Question: Condense the content of this figure into a single sentence.
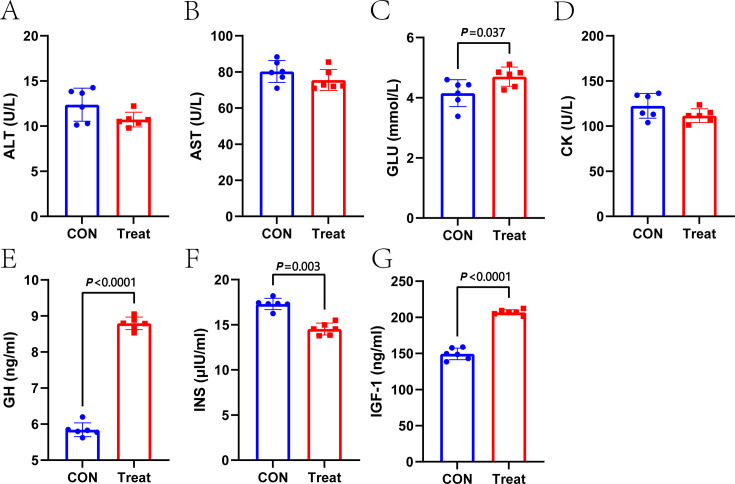
Answer: Effects of supplemental fermented Chinese herbal medicine on serum biochemical and growth hormone parameters in lambs. Data are presented as mean ± SEM. Group comparisons were analyzed using an independent samples t -test. Bar graphs comparing serum biochemical parameters between control and fermented Chinese herbal medicine groups in lambs. ( A ) ALT; ( B ) AST; ( C ) GLU; ( D ) CK; ( E ) GH; ( F ) INS; ( G ) IGF-1. Treatment significantly increased glucose, growth hormone, and IGF-1 levels while decreasing insulin compared to control.